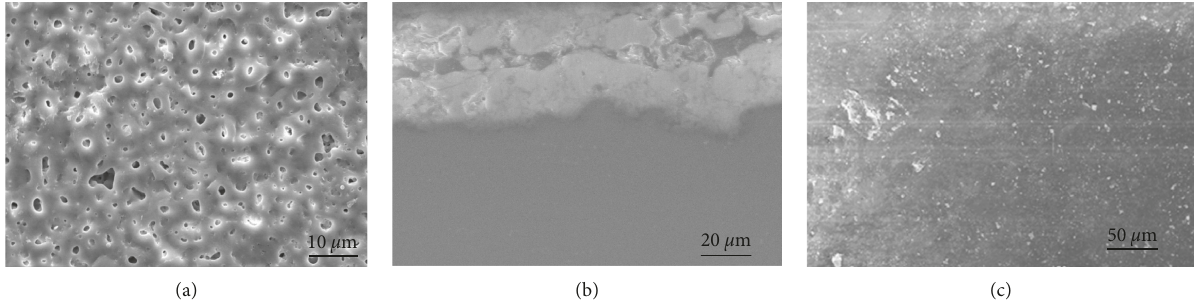
Figure 2: (a) MAO surface morphology, (b) cross sections of MAO, and (c) multiple coating